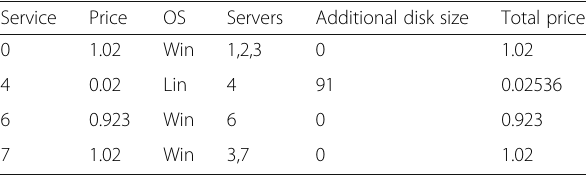
Table 7 Results of service consolidation for the tested application on joyent